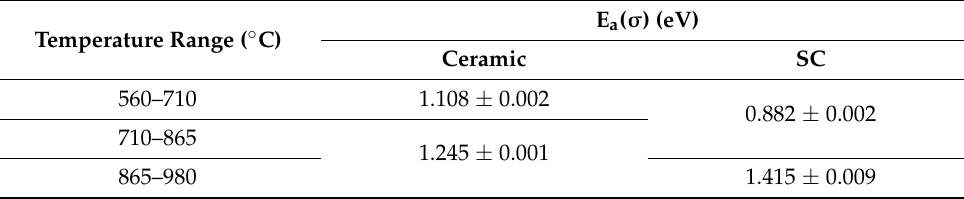
Table 5. Activation energies for the DC conductivity of KNN ceramics and single crystal